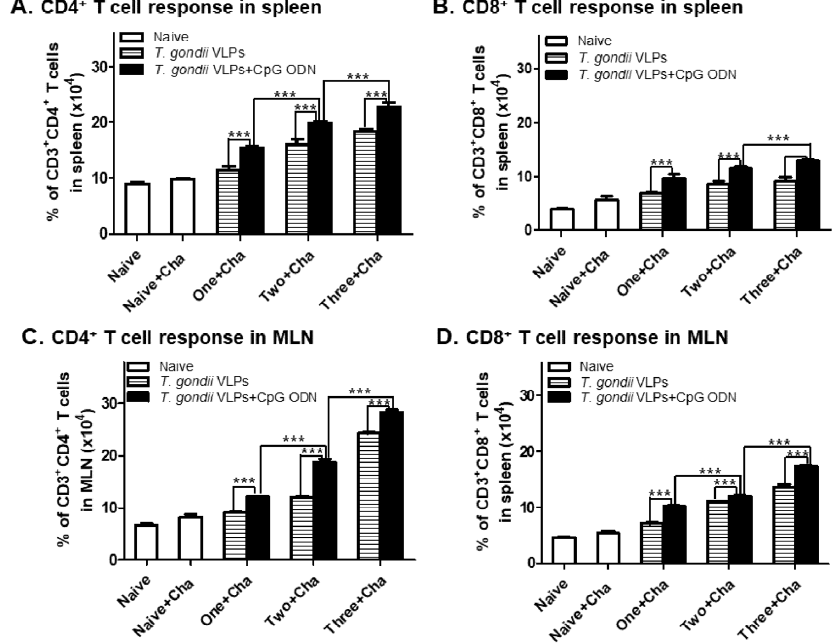
Figure 4. Immunization with CpG-ODN-adjuvanted T. gondii VLPs enhances CD4 + ( A , C ) and CD8 + ( B , D ) T-cell frequencies. BALB / c mice ( n = 6 per group) immunized one, two, or three times were challenge-infected with T. gondii ME49, 4 weeks after the last immunization. Spleen and MLN tissues were harvested at 35 dpi and then cell phenotypes were determined by flow cytometry with or without T. gondii antigen stimulation. Results are presented as mean ± SD and statistical significances were denoted using asterisks (*** p < 0.001) .